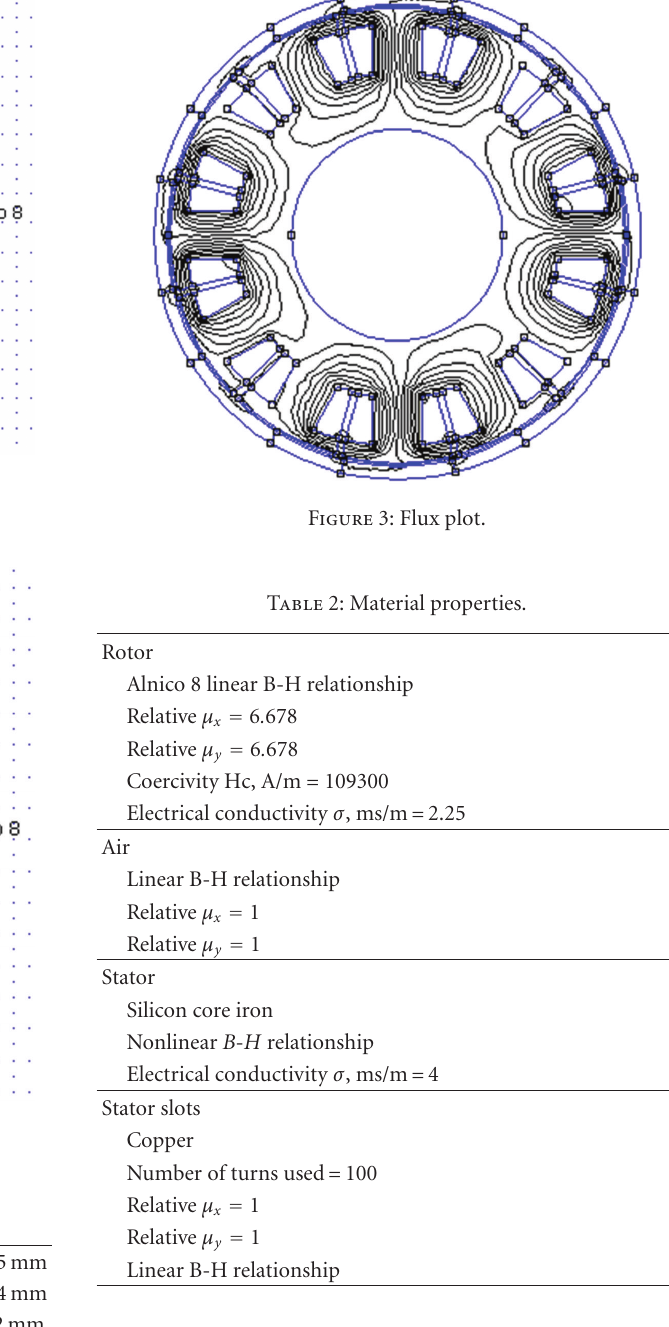
Figure 2. Flux lines established, and flux density